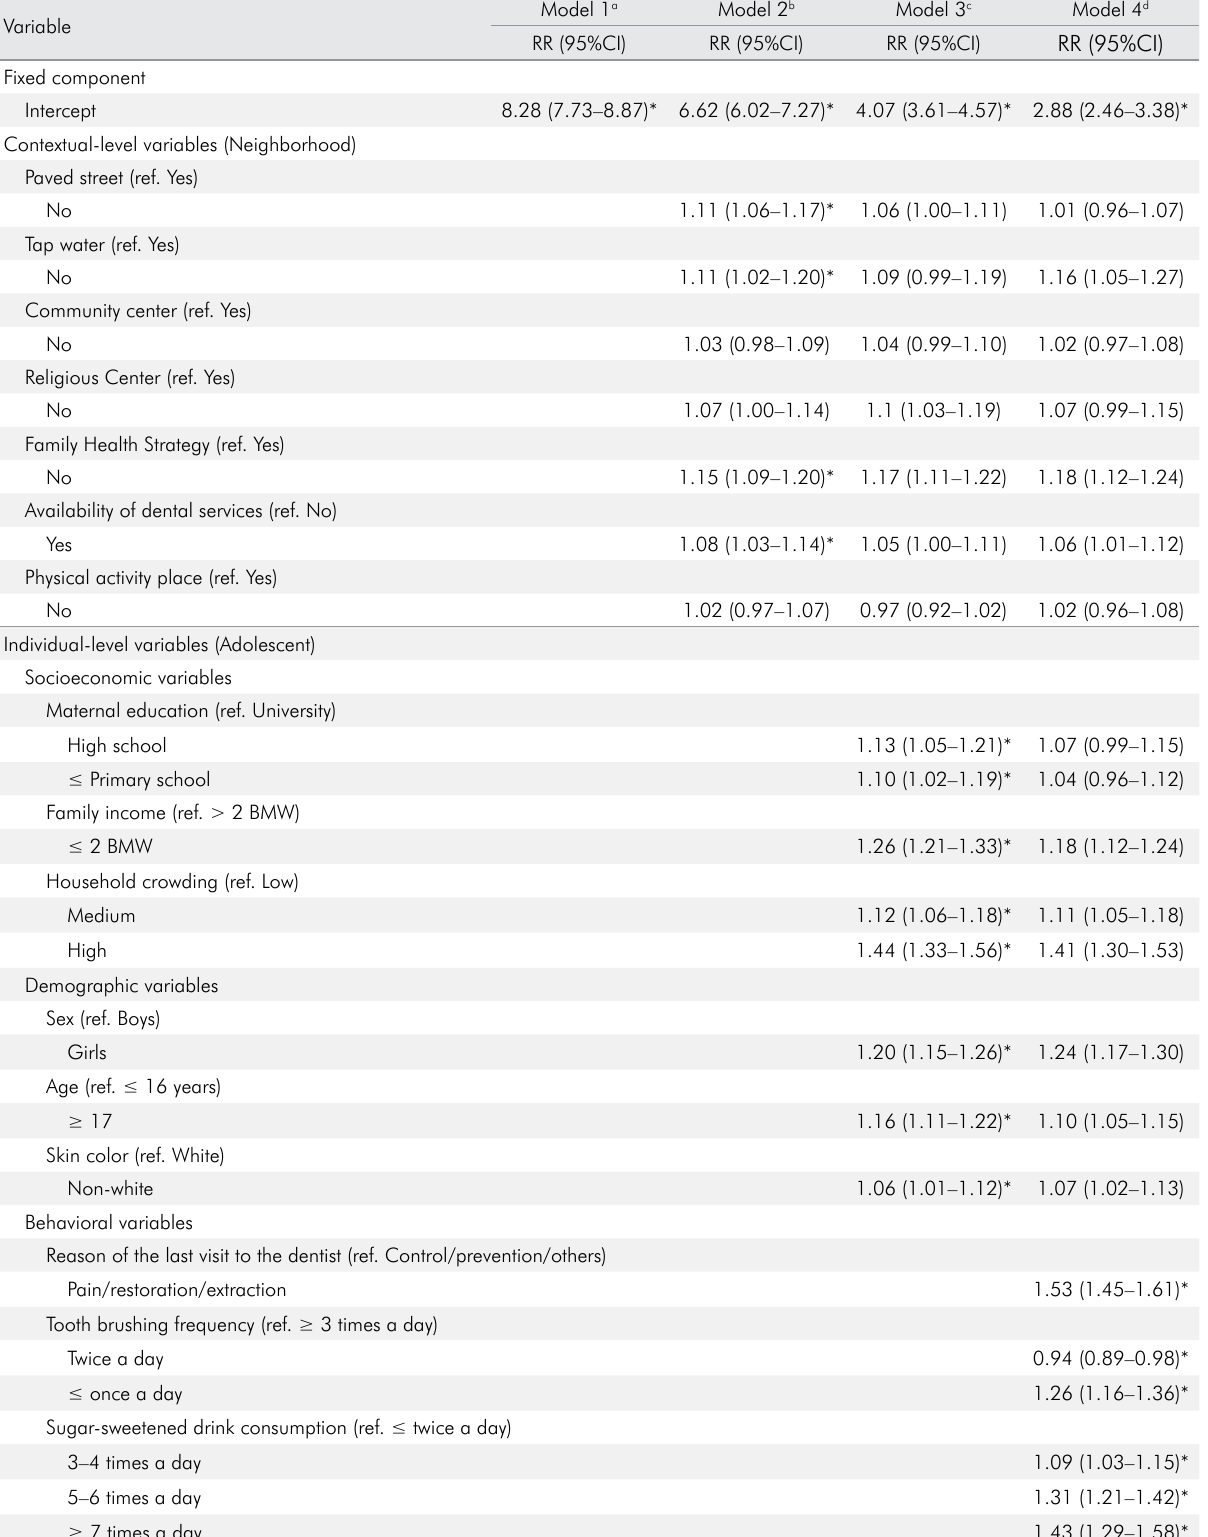
Table 2. Adjusted association between explanatory variables and OHIP-14 scores. Multilevel Poisson regression analysis.